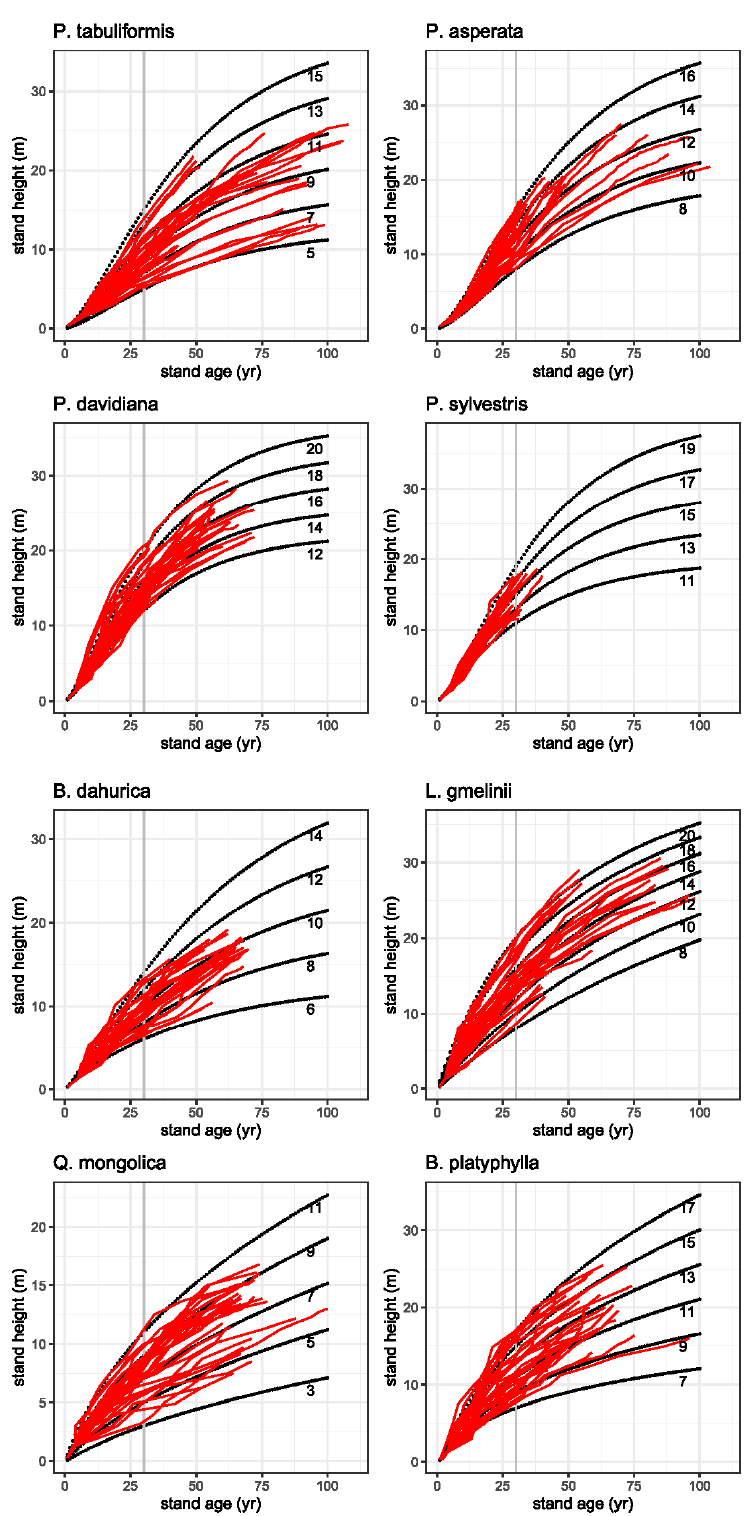
Figure 2. Productivity of forest sites classified by stand height (m) at a given stand age (years) represented on a top height growth scale (22 m, 20 m, . . . 5 m, 3 m) for each tree species. Modeled top height growth curves (dashed black lines) obtained using several growth models at a reference age of 30 years (grey line) overlaid on the trajectories of the observed top heights of the trees (red lines).